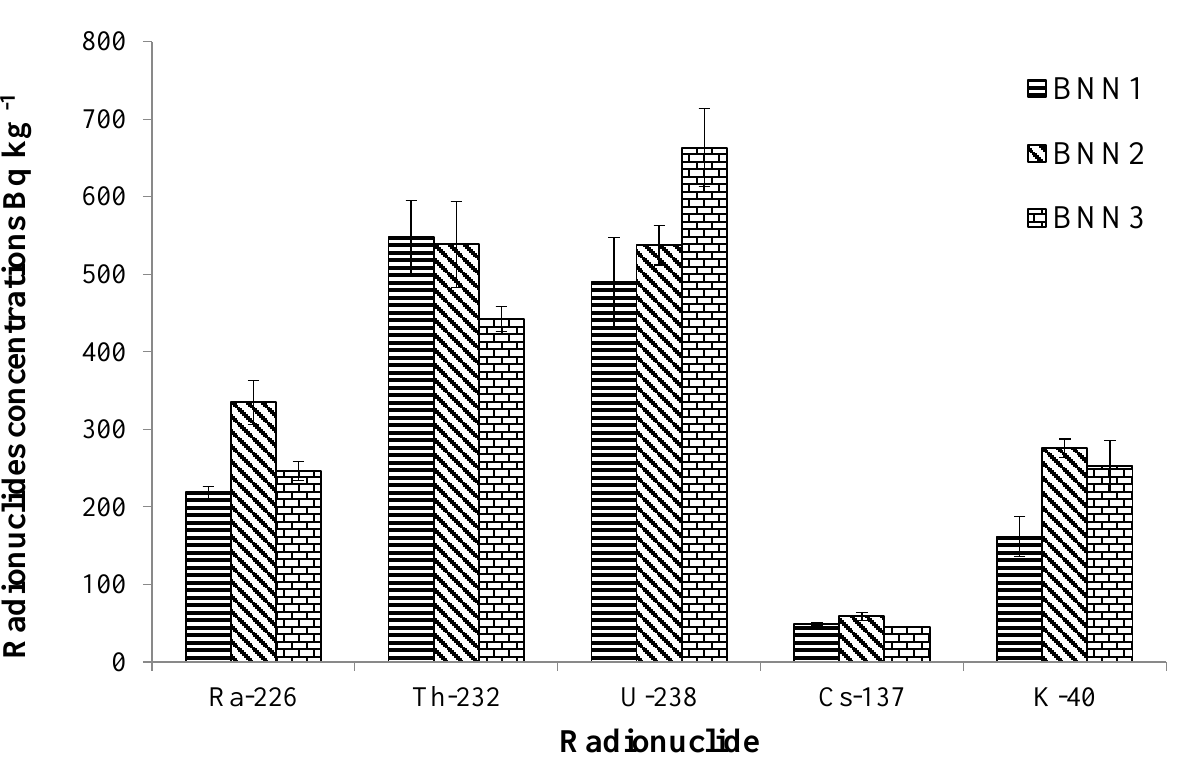
Figure 2. Mean activity concentrations of radionuclides in sediments of Bonny estuary.